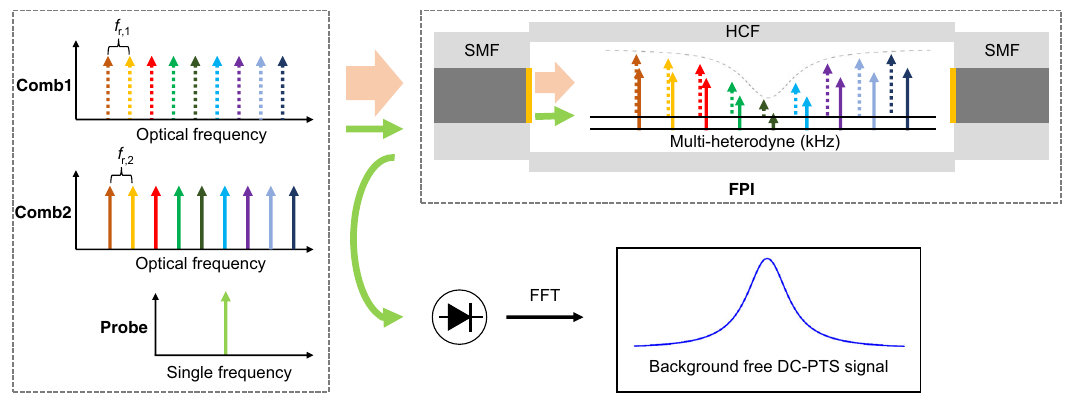
Fig. 1 Principle of dual-comb photothermal spectroscopy (DC-PTS). FPI Fabry-Pérot interferometer, SMF single-mode fi ber, HCF hollow-core fi ber, f r,1 , f r,2 repetition frequencies of the two frequency combs, FFT Fast Fourier Transform. Two frequency combs heterodyne against each other to provide a set of amplitude modulations at the down-converted evenly-spaced frequencies. The combs and a probe laser are coupled into a FPI formed by a HCF sandwiched by two solid-core SMFs. The refractive index of the target gas in the HCF is modulated by the pump comb source, leading to the phase modulation of the probe laser. The output of the probe laser from the FPI is used to retrieve the multi-heterodyne photothermal signal by Fourier